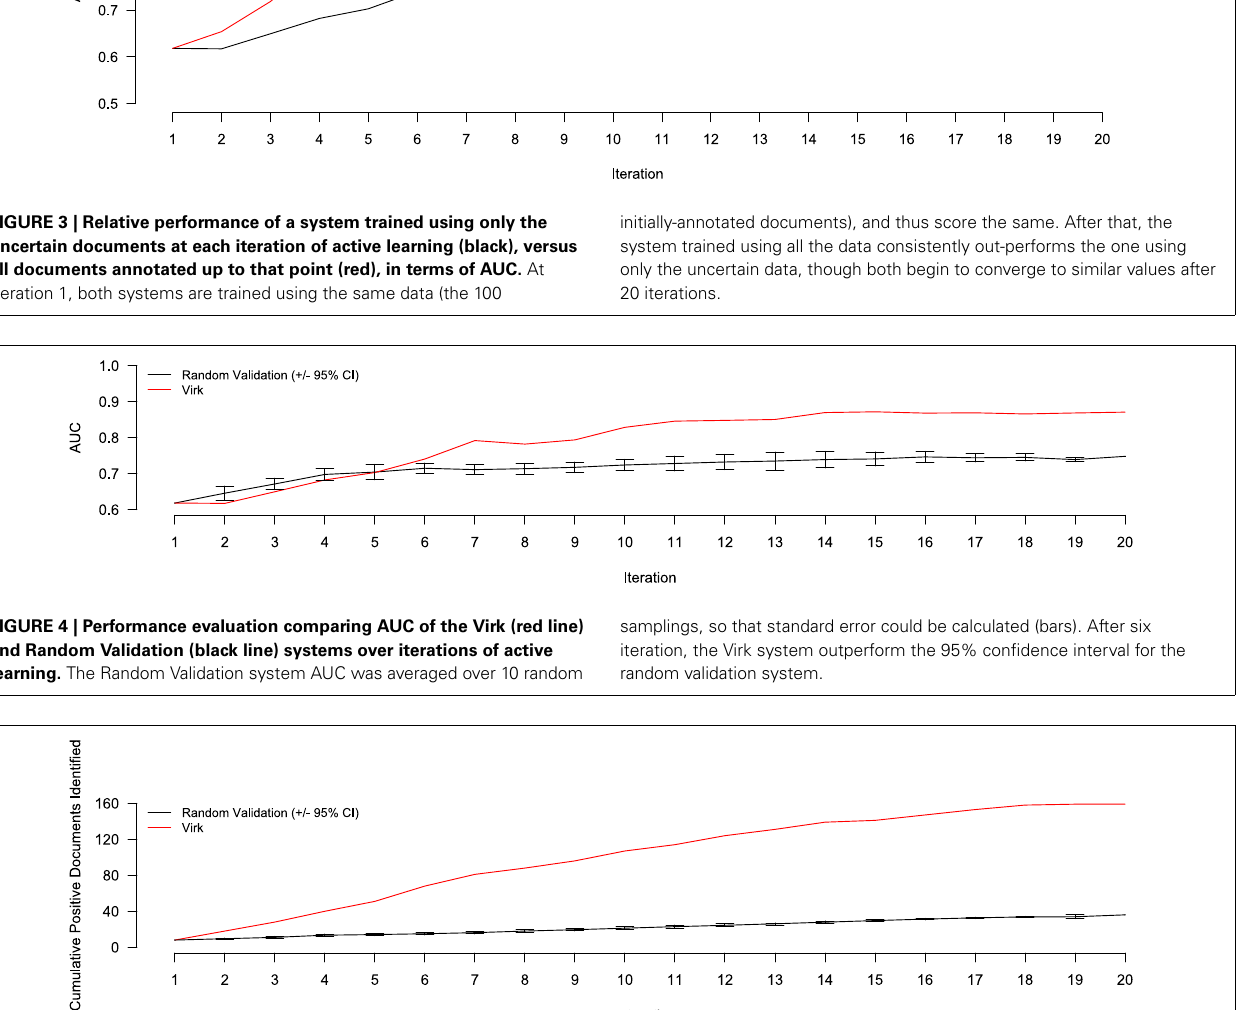
iteration (compared to approximately 8.0, by Virk). Thus,